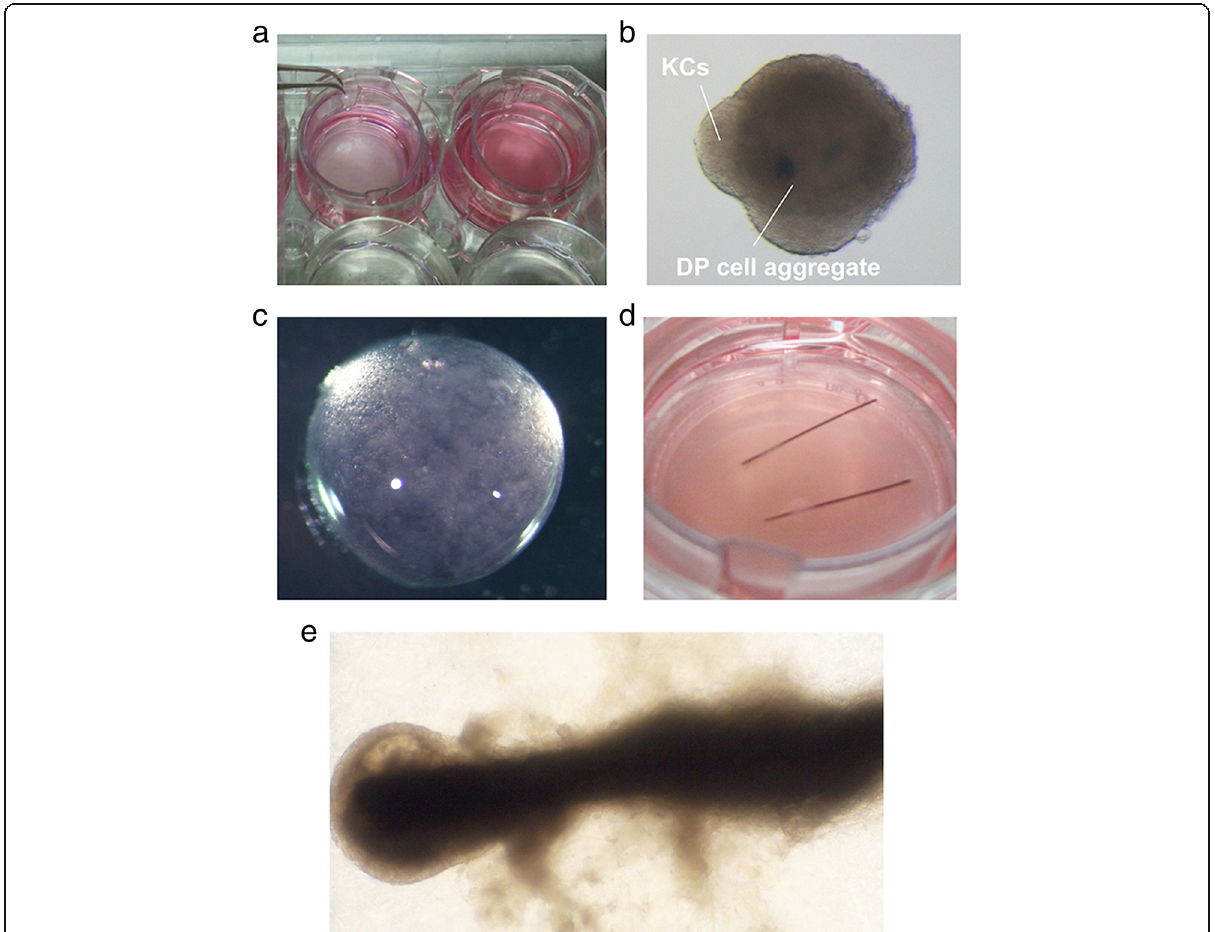
Fig. 3 In vitro approaches to elicit folliculogenic EMI. a Co-culture of hair follicle epithelial and mesenchymal components using cell inserts. b Formation of spheres in which keratinocytes (KCs) are covering a dermal papilla (DP) cell aggregate. c Compartmentalization of KCs and DP cells in a collagen gel droplet. d Reproduction of hair follicle-like structures made of human KCs and DP cells in Matrigel. e Regenerated HF-like structure in Matrigel. The data shown in ( d , e ) are obtained in a preliminary experiment supported by JSPS KAKENHI (Grant Number JP 16H05370 to